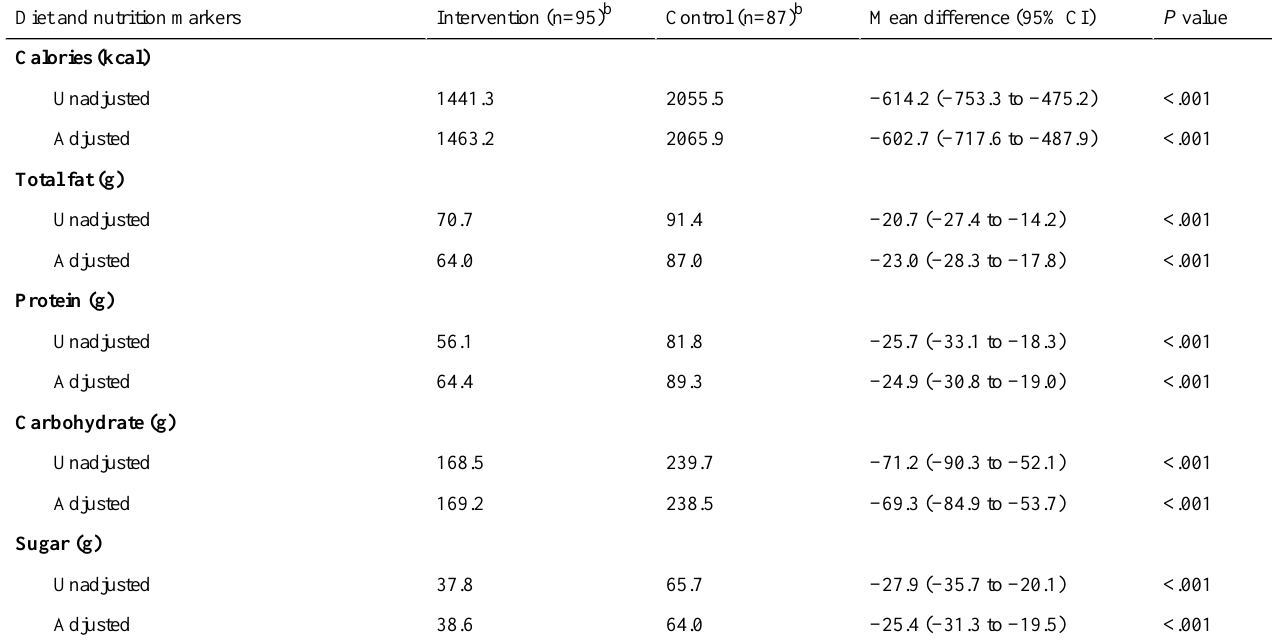
Table 3. Mean nutritional intake in the intervention and control and their mean differences at month 4 a .